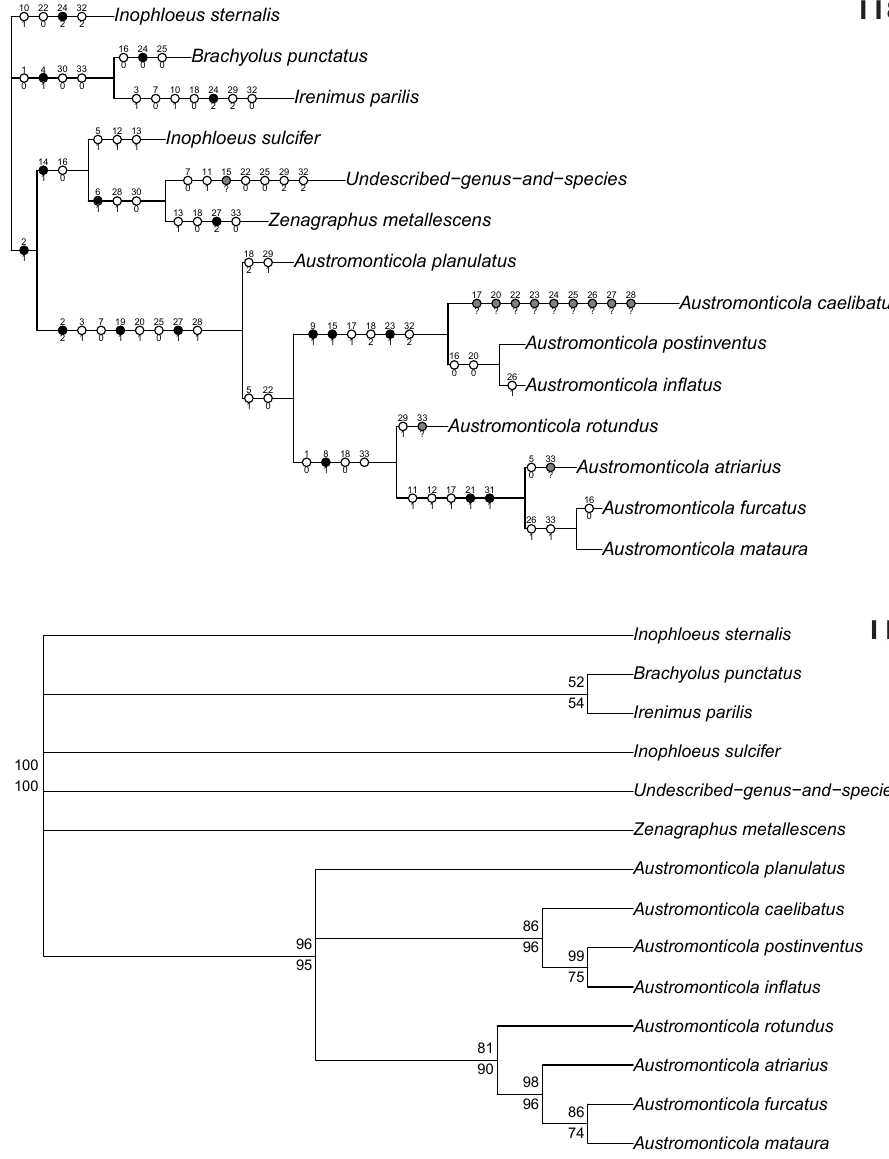
Figures 118–119. Cladograms showing phylogenetic relationships between Austromonticola species as inferred from morphological data. 118 single most parsimonious tree inferred from 33 characters scored for 14 species 119 phylogenetic tree of Austromonticola with bootstrap values above nodes and jackknife values below. Nodes with lower than 50% support were